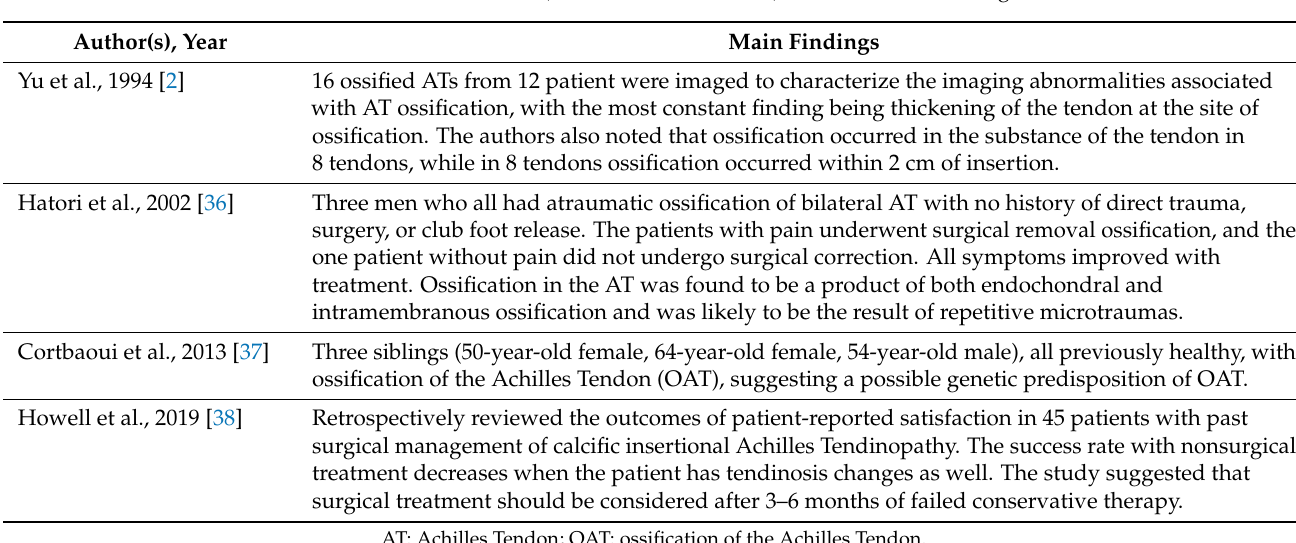
Table 4. Relevant articles (Case Series; 1994–2013) and their main findings.